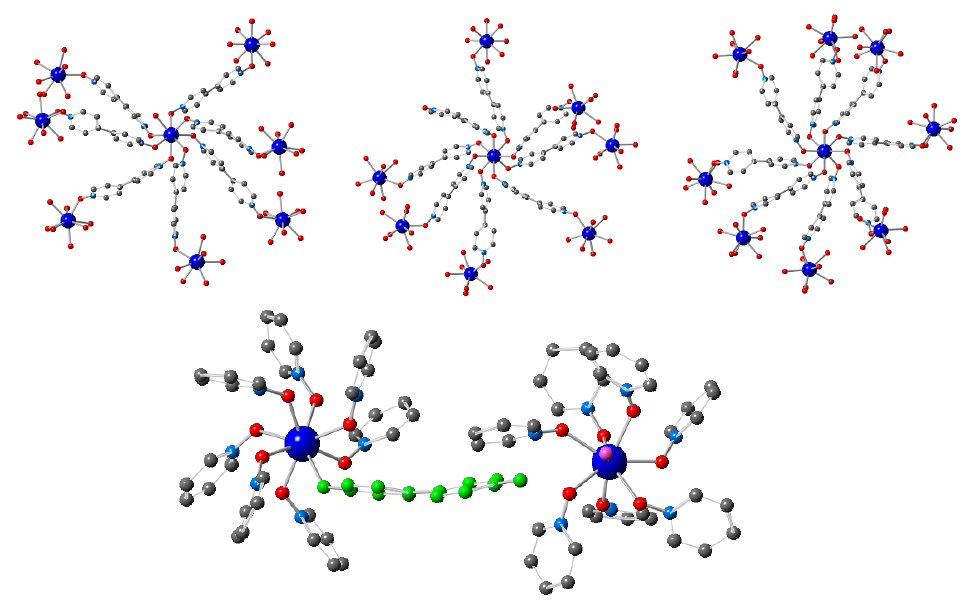
Figure 7. ( Top ) View of the three crystallographically independent Gd centers in 1–AuCl 4 : Gd1, Gd2 and Gd3. Gd1 has a coordinated water molecule (in addition to 7 bridging bipyNO ligands), Gd2 has a terminal bipyNO ligand (in addition to 7 bridging bipyNO ligands), and Gd3 is coordinated to 8 bipyNO ligands that serve as bridges between Gd centers. ( Bottom ) Close view of the coordination environment of Gd1 and Gd2, highlighting the presence of a terminal bipyNO ligand (in green ) and a coordinated water molecule (in pink ).